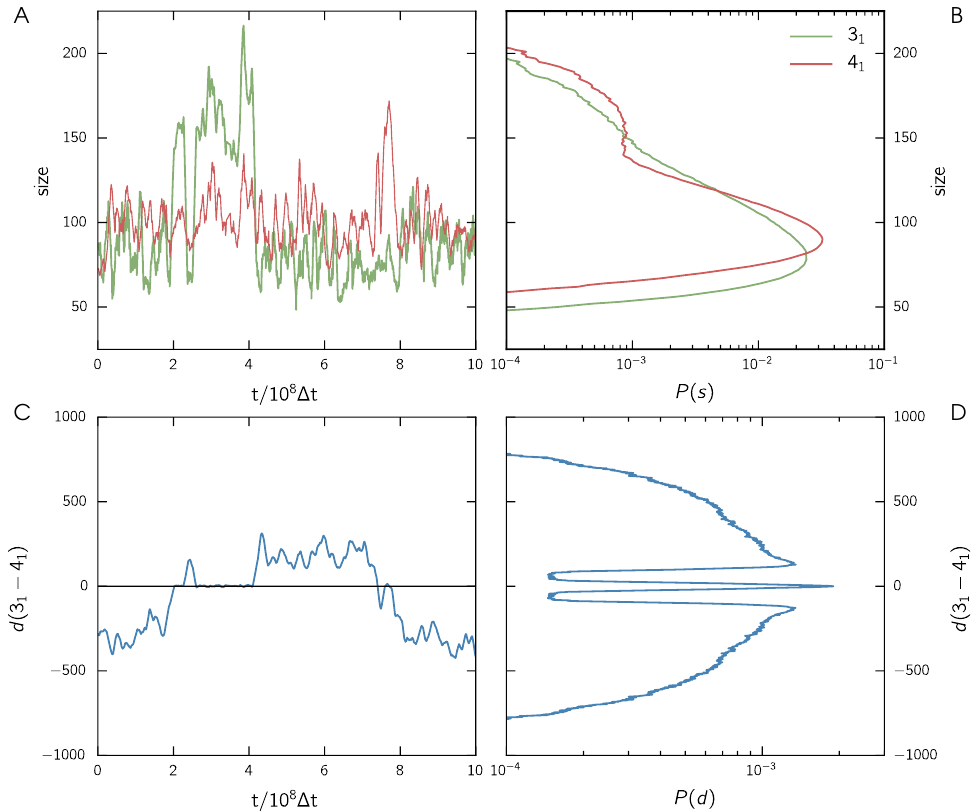
Figure 3. Knot swapping events for wall distance 500 σ . ( A ) Short excerpt from the time evolution of knot sizes for the trefoil knot 3 1 and the figure-of-eight knot 4 1 in green and red, respectively; ( B ) Probability distribution in log-scale of knot sizes; ( C ) Short excerpt from the time evolution of the distance between the two knots; ( D ) Probability distribution in log-scale of the knot